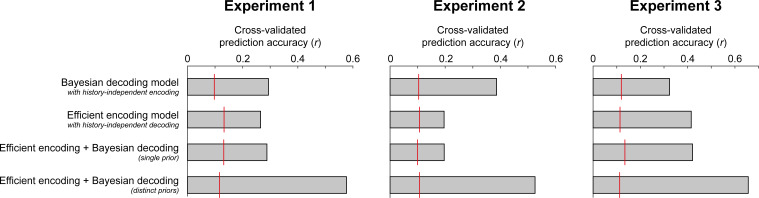
Cross-validated prediction accuracies of the four different observer models.Across all three experiments, an ideal observer model with efficient encoding and Bayesian decoding optimized according to distinct priors (distinct transition distributions and integration time constants) provided the best fits to the held-out testing data. It consistently outperformed an ideal observer model in which encoding and decoding were based on the same predictions (single prior), or models in which the sensory history influenced only Bayesian decoding or only efficient encoding. Importantly, those models could not qualitatively account for all aspects of the empirical bias pattern, being limited to producing only attractive or only repulsive biases. A baseline level of chance prediction accuracy of each model is indicated by the red lines. To this end, we randomly permuted the models’ predicted responses to the stimuli in the testing dataset, thereby abolishing the trial correspondence between model and participant errors, and computed the correlation between the resulting permuted model predictions and observed serial dependence curves. This procedure was repeated 1000 times. The red line indicates the 95th percentile of the resulting permutation distribution.